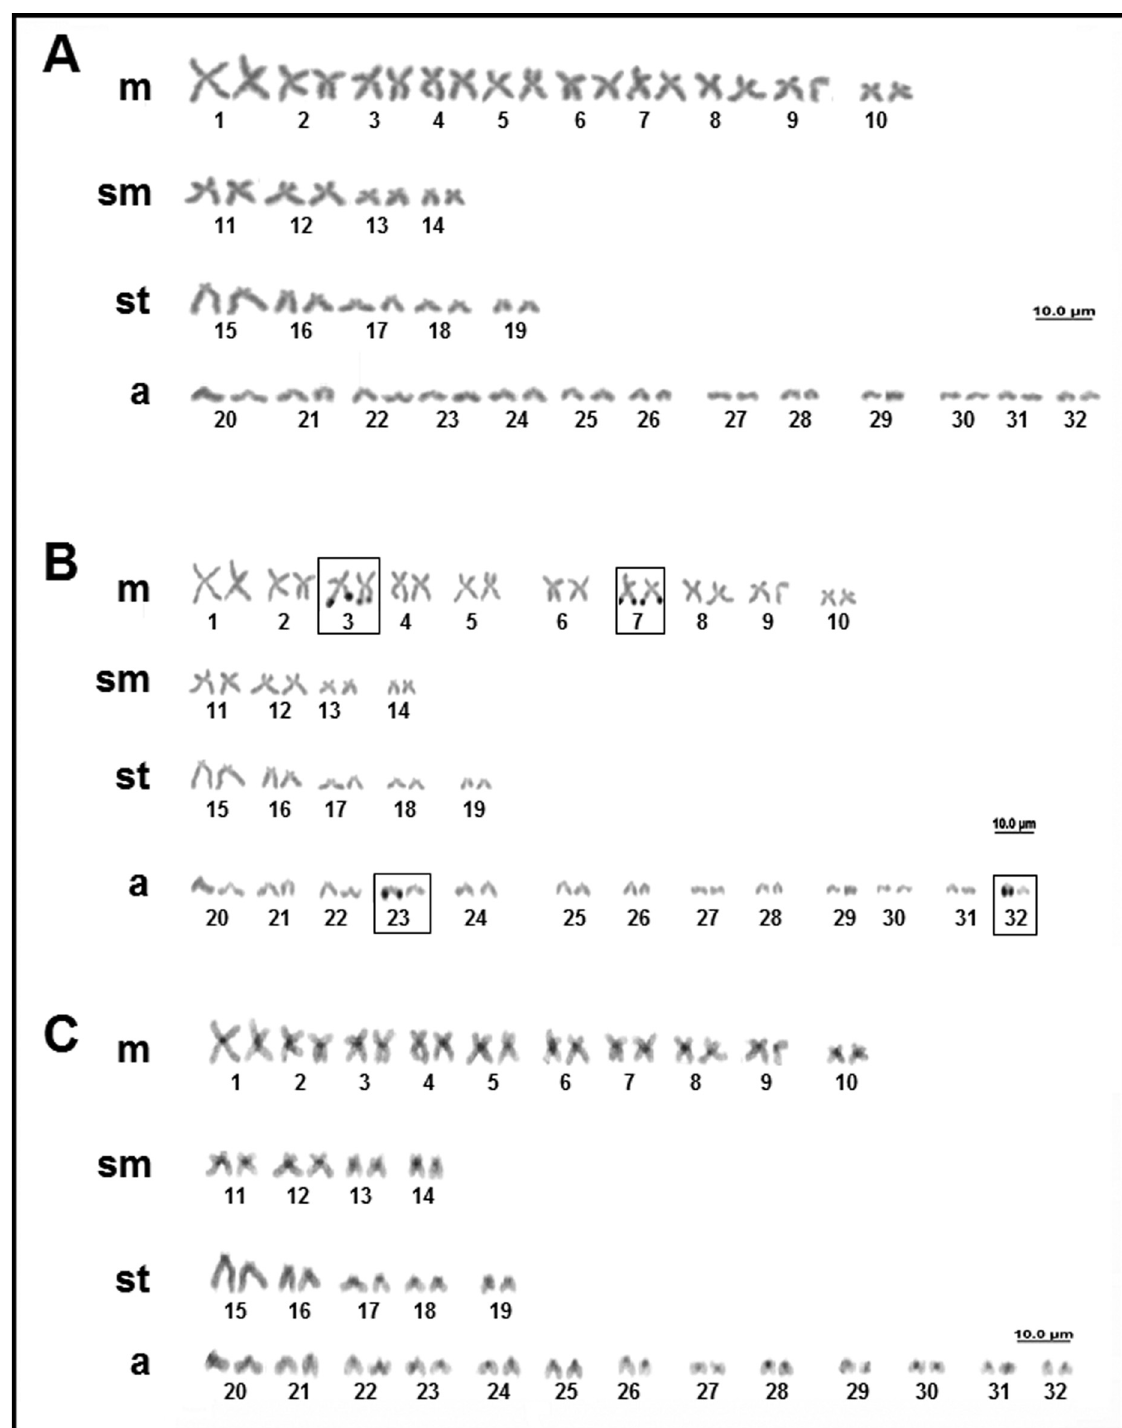
Figure 5 - Karyotype of Potamotrygon leopoldi : (A) conventional Giemsa staining; (B) sequential AgNO 3 ; (C) sequential